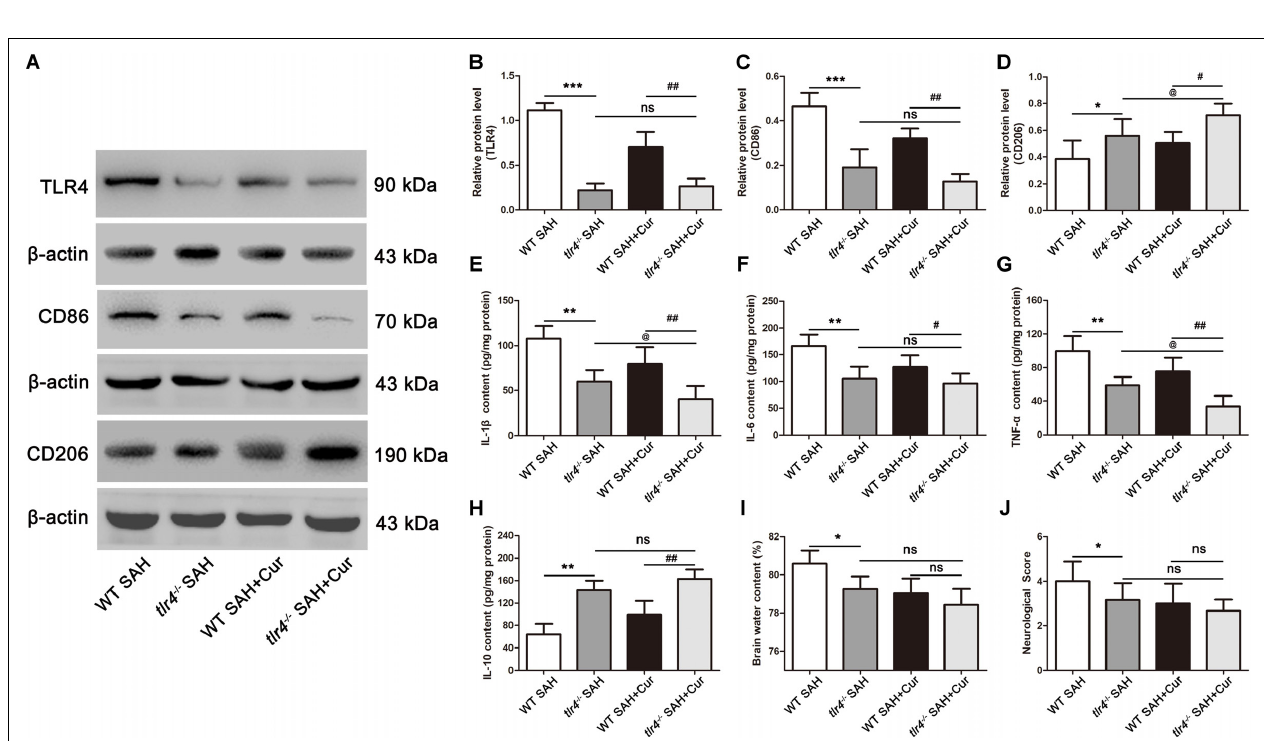
FIGURE 8 | TLR4 deficiency enhanced the effects of curcumin on microglia phenotype switch into M2 at 24 h after SAH. (A) Western blotting showed that TLR4 deficiency reduced the protein levels of TLR4 (B) and CD86 (C) post SAH as compared with the wild type (WT) SAH group, and increased the expression of CD206 (D) . Curcumin treatment in tlr4 − / − group further elevated the level of CD206 as relative to the tlr4 − / − SAH group and had no statistic difference on TLR4 and CD86. (E–H) ELISA showed that the contents of IL-1 β (E) , IL-6 (F) , TNF- α (G), and IL-10 (H) significantly changed in tlr4 − / − SAH group compared with the WT SAH group, and curcumin treatment in tlr4 − / − mice further suppressed the release of pro-inflammation cytokines (IL-1 β and TNF- α ) and increased the level of IL-10 as relative to the tlr4 − / − SAH group. (I,J) Curcumin treatment in tlr4 − / − mice had no significant difference on brain water content and neurological score as relative to the tlr4 − / − SAH group and WT SAH + Cur group. The quantitative data are the mean ± SD ( n = 9, each; ∗ p < 0.05, ∗∗ p < 0.01, ∗∗∗ p < 0.001 vs. WT SAH group; # p < 0.05, ## p < 0.01 vs. WT SAH + Cur group; @ p < 0.05 vs. tlr4 − / − SAH group; ns p > 0.05).